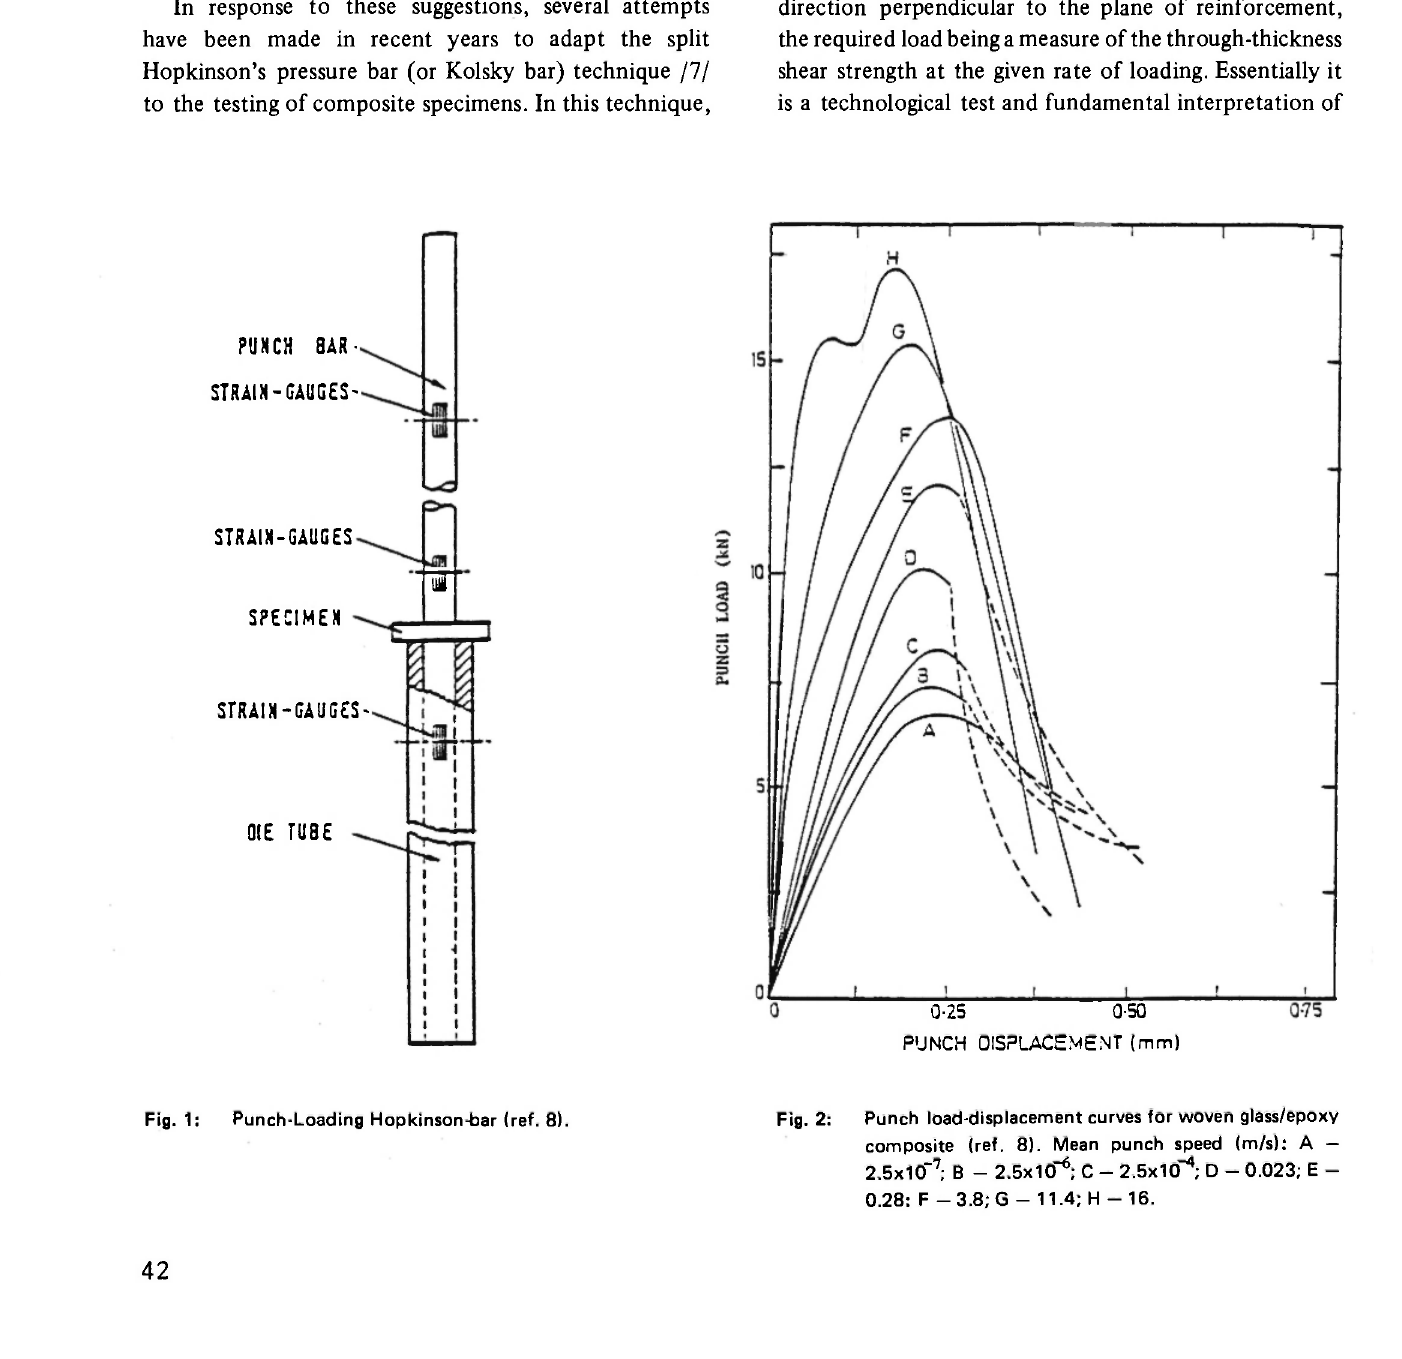
Fig. 1: Punch-Loading Hopkinson-bar (ref. 8). Fig. 2: Punch load-displacement curves for woven glass/epoxy